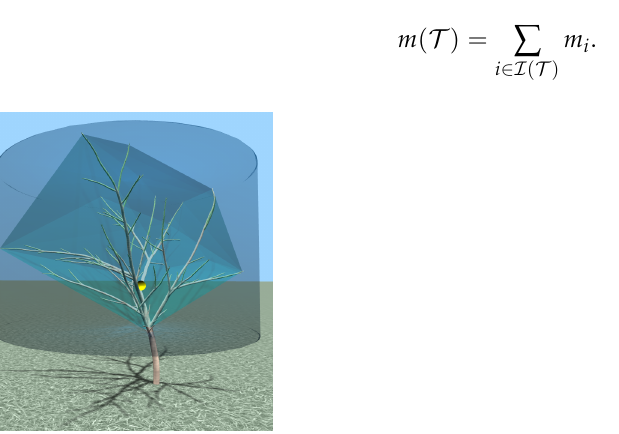
, its bounding cylinder H